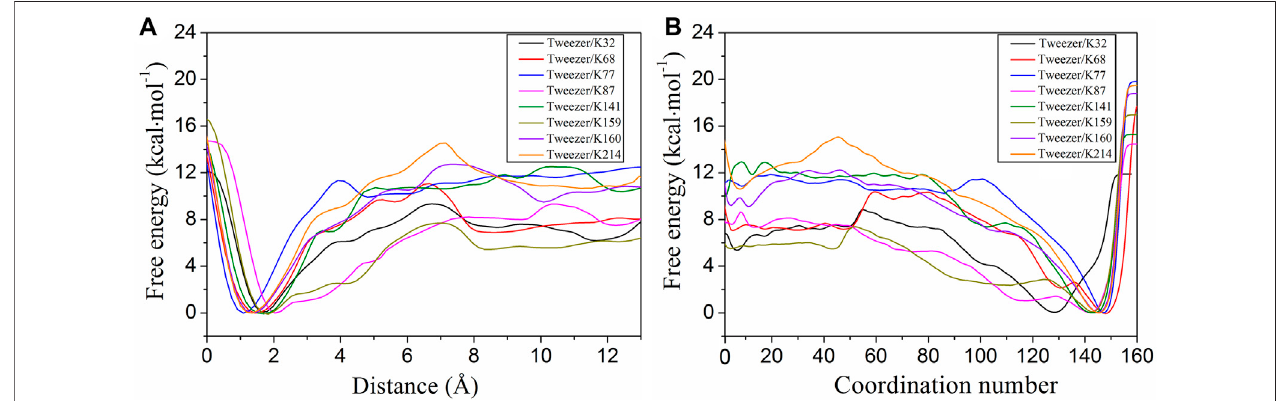
FIGURE 2 | One-dimensional free energy pro fi les extracted from the two-dimensional free energy surfaces with respect to the distance (CV1) and coordination number (CV2) for the tweezer binding to the eight putative binding sites (K32, K68, K77, K87, K141, K159, K160, and K214). The free energy of the bound state was de fi ned as zero for the tweezer binding to lysine sites. CV1 is the distance between the center of mass (COM) of the lysine side chain and the COM of the tweezer ring, excluding the two phosphate groups. CV2 represents the coordination number between the heavy atom in the side chain of lysine and the carbon atom in the tweezer